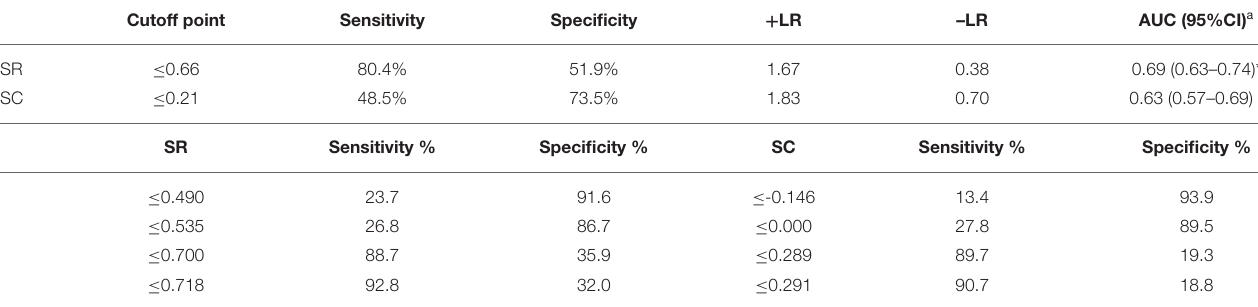
TABLE 5 | ROC analysis for differentiation of prostatic/bladderneck fistulae from bulbar